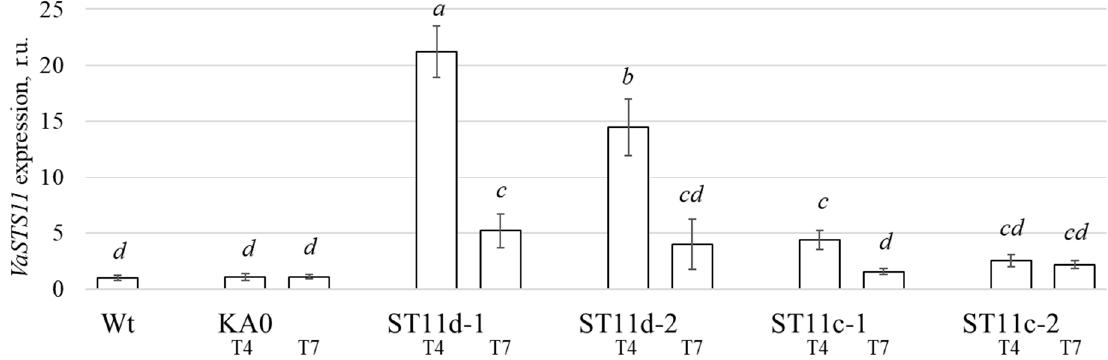
Figure 1. Quantification of the VaSTS11d and VaSTS11c transgene expression levels in transgenic Arabidopsis thaliana of T 4 and T 7 generation performed by quantitative RT-PCR. Wt—wild-type A. thaliana plants; KA0—the control KA0 A. thaliana plants transformed with the vector harboring only the npt II selective marker; ST11d-1, ST11d-2—two transgenic lines of A. thaliana plants transformed with the intron-containing VaSTS11d ; ST11c-1, 2— A. thaliana plants transformed with the intronless VaSTS11c ; r.u.—related units; T 4 and T 7 — VaSTS11d- and VaSTS11c- transgenic A. thaliana in the fourth (T 4 ) and seventh (T 7 ) generations. The data are presented as mean ± SE (two independent